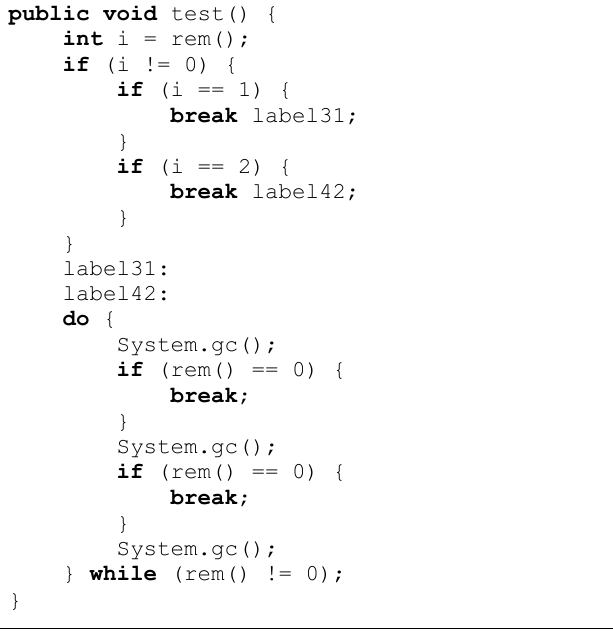
Fig. 14. JD Project decompilation result.